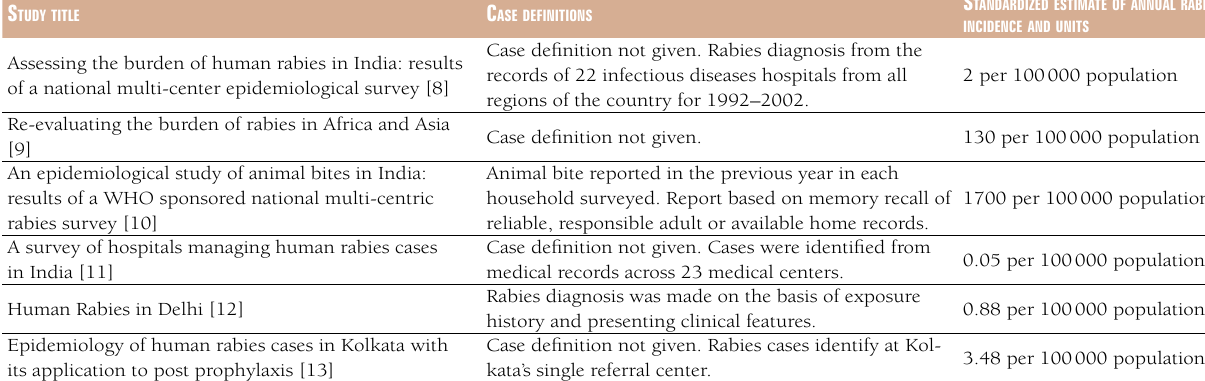
Table 1 Case definitions used in studies of rabies in India in the past